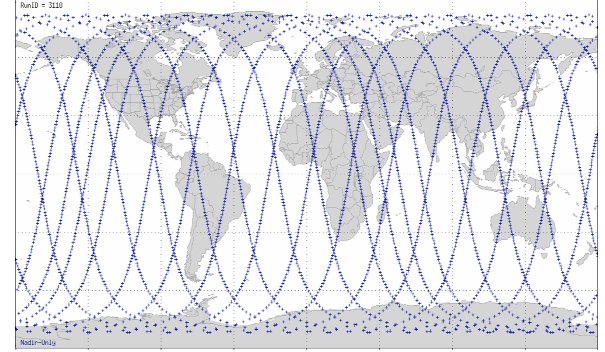
Fig. 1. An example of the nadir orbit of Tropospheric Emission Spectrometer for a particular global survey.